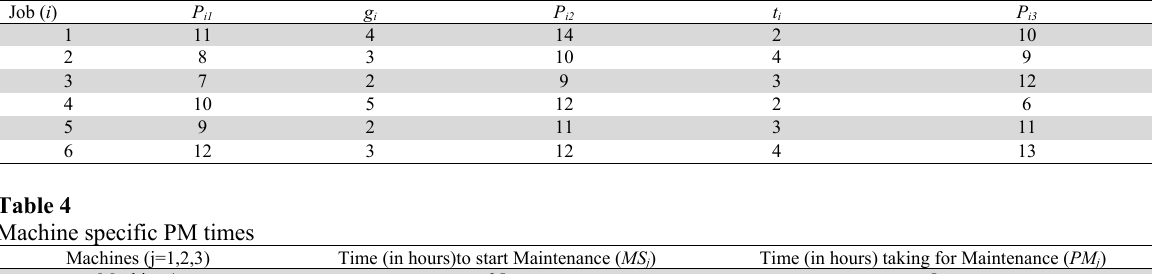
Numerical instance with conveyance times